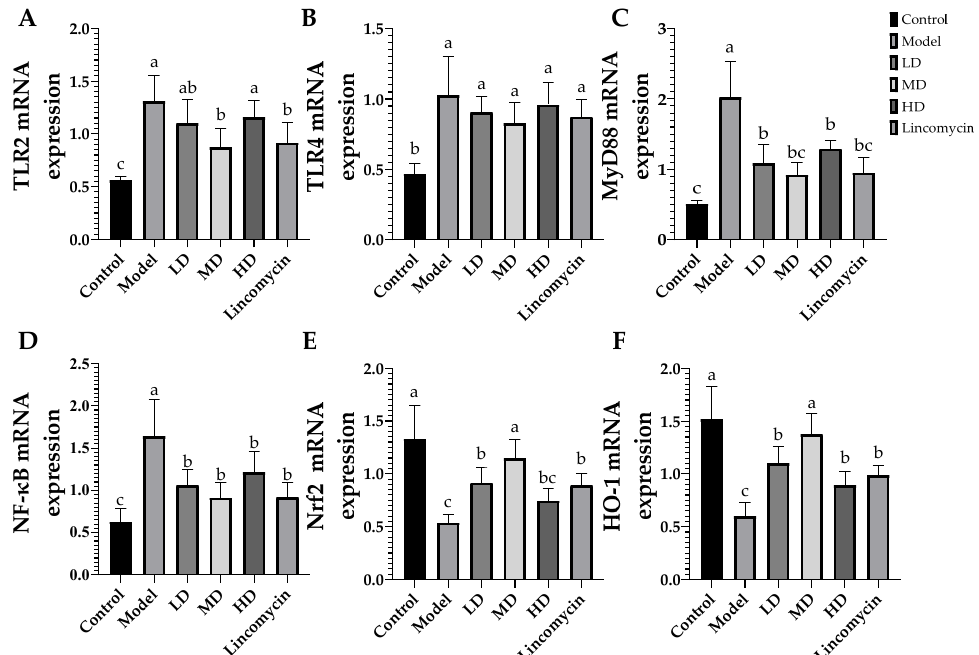
Figure 8. Relative mRNA expression of inflammation- and antioxidation-associated factors in the jejunal tissue. ( A ) Toll-like receptor 2 (TLR-2); ( B ) Toll-like receptor 4 (TLR-4); ( C ) myeloid differen- tiation primary response protein (MyD88); ( D ) nuclear factor kappa B (NF- κ B); ( E ) nuclear factor erythroid 2-related factor 2 (Nrf-2); ( F ) heme oxygenase 1 (HO-1). Values with the same superscript letters in the same line were not significantly different ( p > 0.05); values with different letters were significantly different ( p < 0.05).